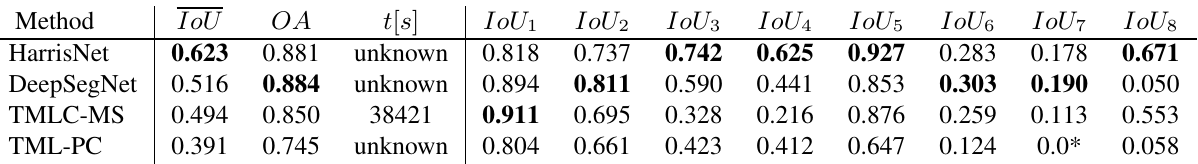
Table 1: Semantic3d benchmark results on the full data set: 3D covariance baseline TMLC-MS , 2D RGB image baseline TML-PC , and first submissions HarrisNet and DeepSegNet . IoU for categories (1) man-made terrain, (2) natural terrain, (3) high vegetation, (4) low vegetation, (5) buildings, (6) hard scape, (7) scanning artefacts, (8) cars. * Scanning artefacts were ignored for 2D classification because they are not present in the image data.